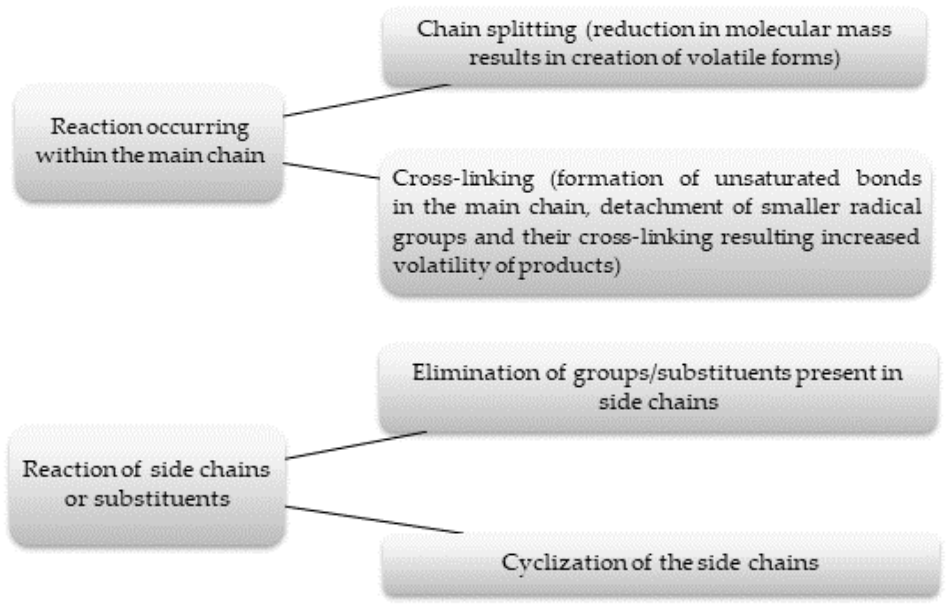
Figure 5. Mechanism of polymers’ decomposition.